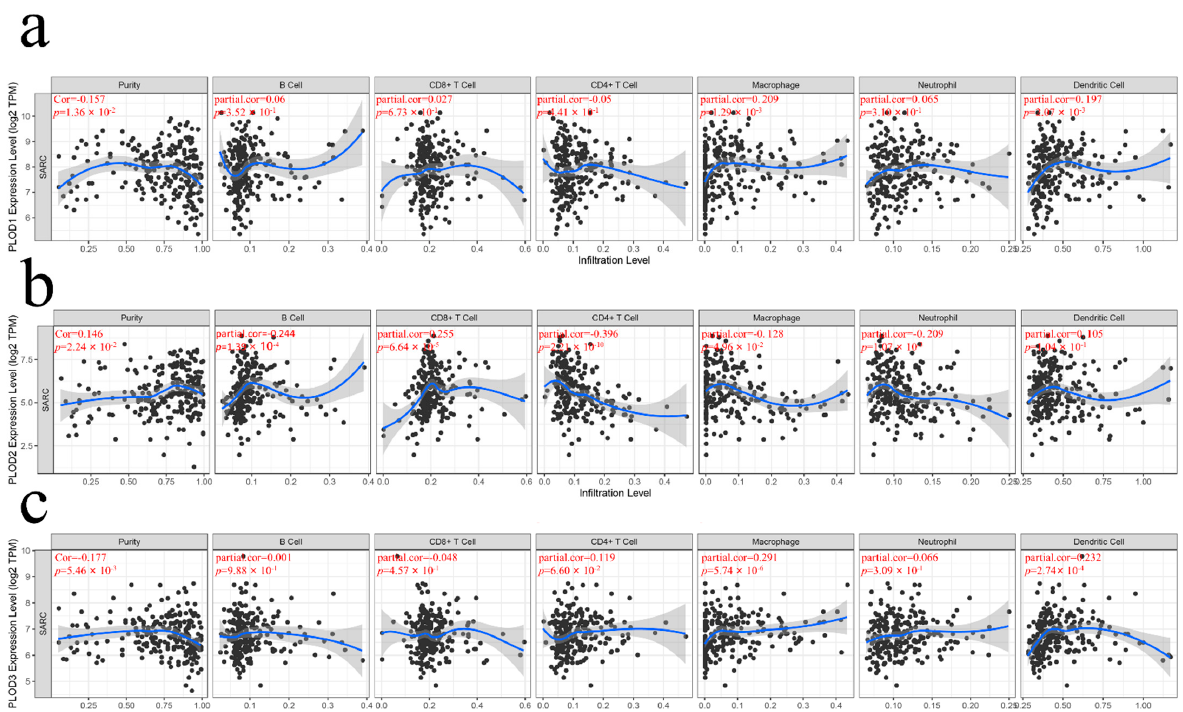
Figure 5. Correlations of PLOD family members’ expression with immune cells infiltration level in STS. The correlation between expression of ( a ) PLOD1, ( b ) PLOD2, ( c ) PLOD3, and each type of tumor immune infiltration cells.